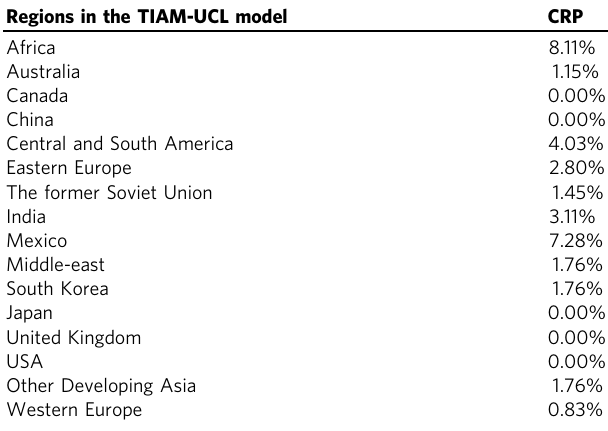
Table 2 Country risk premiums across countries and